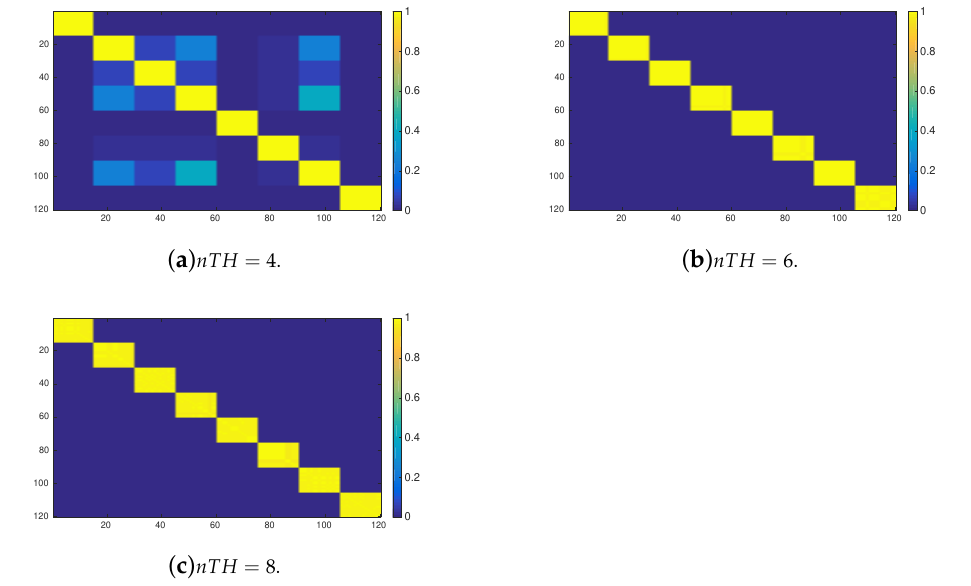
Figure 9. Possibilistic transition matrix, induced by the YPRF, powered after reaching a stationary possibilistic distribution ( P τ ) for the 120 tasks arranged into 8 clusters and different values of nTH